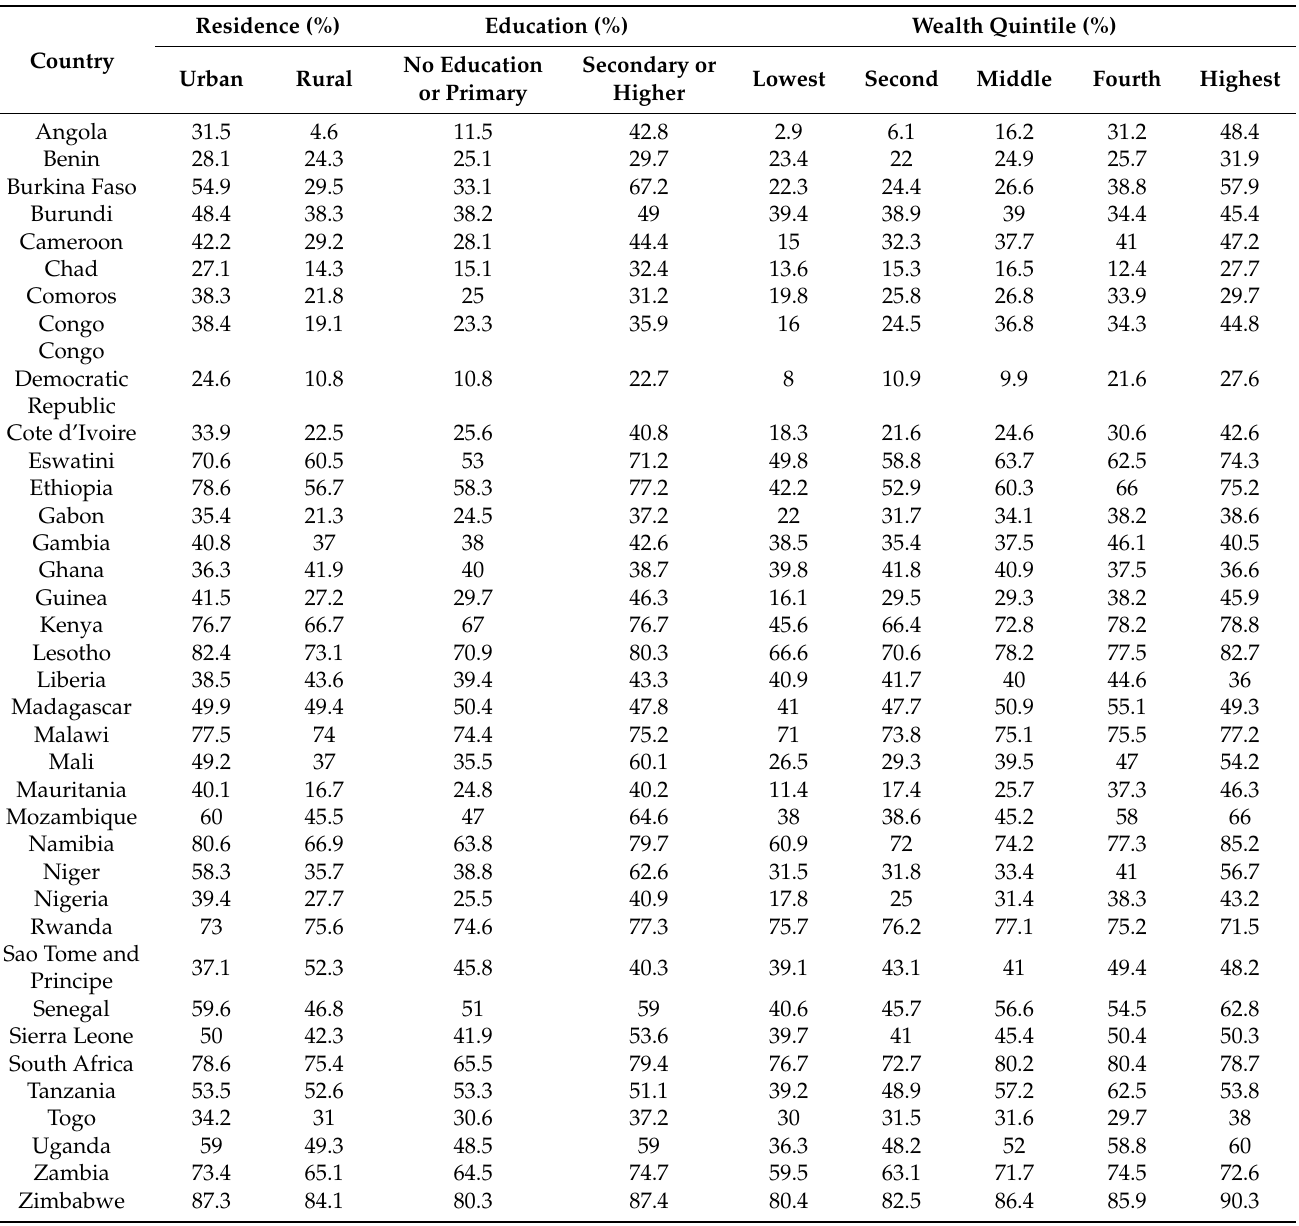
Table 4. Distribution of demand for family planning satisfied by modern methods among women in sub-Saharan